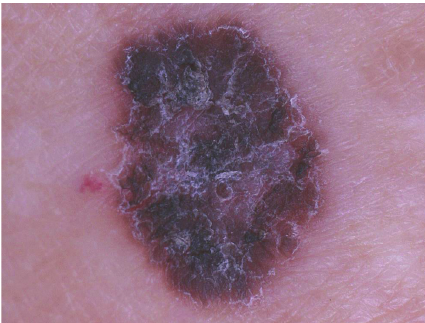
Figure 1: A solitary oval shaped brown-black macule of 8.7 × 11.1mm with whitish scaly surface was seen on the right upper arm.